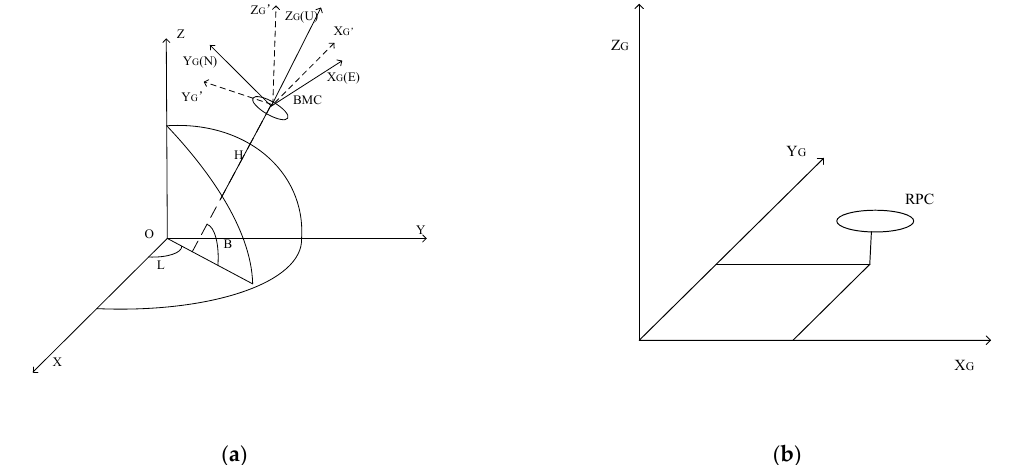
Figure 15. Illustration of the reason for attitude errors. ( a ) Shows the vertical direction of the carrier coordinate system which is inconsistent with that of the ellipsoid geodetic coordinate system due to the buoy attitude changing, ( b ) shows coordinates of the antenna phase center in carrier coordinate system. RPC: receiver phase center, BMC: buoy mass center.